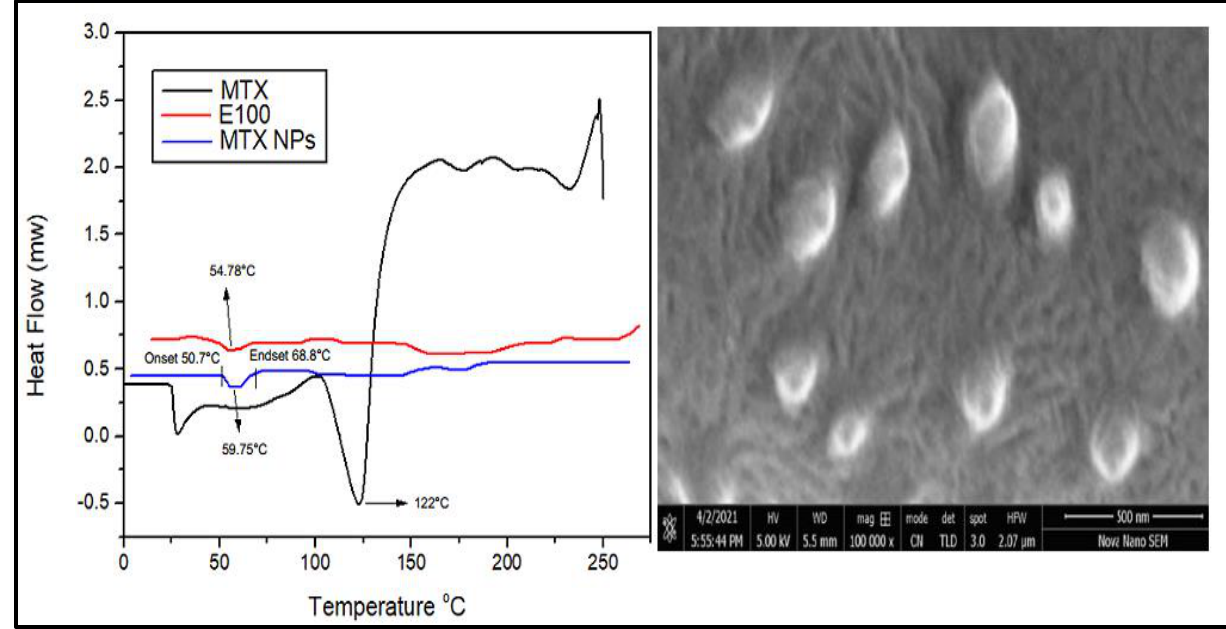
Figure 5. ( a ) Differential scanning calorimetry (DSC) thermograms of MTX, E100 and MTX - NPs. ( b ) Scanning electron microscope image of MTX - NPs.